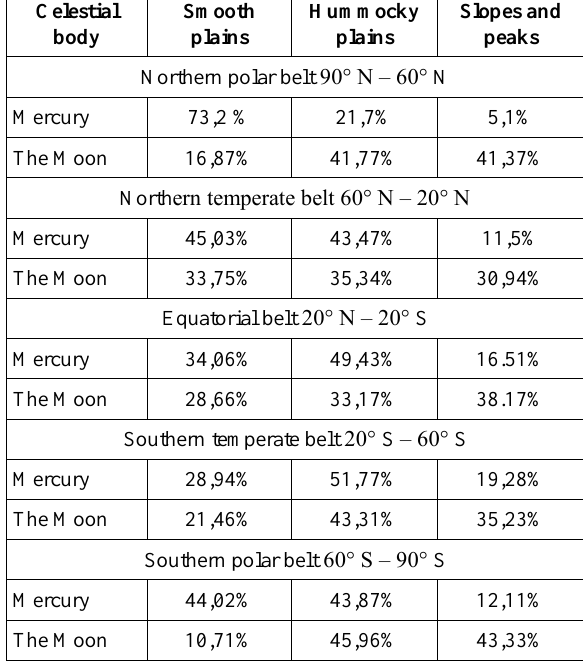
Table 2. Distribution of areas within latitudinal belts,